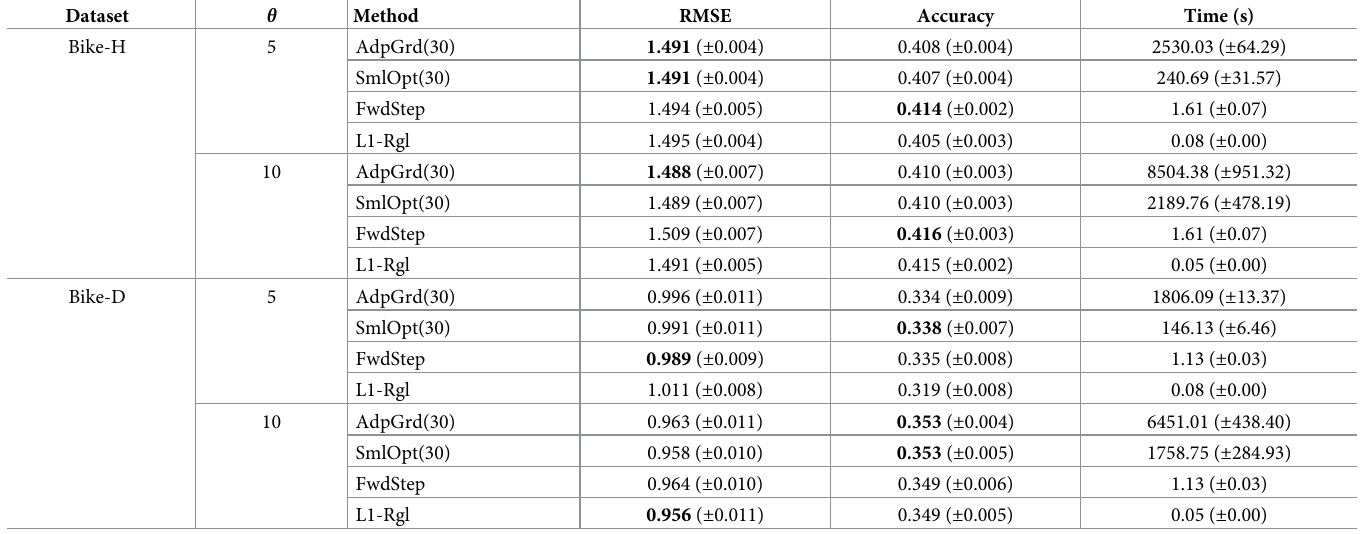
Table 7. Prediction performance for real-world test instances.